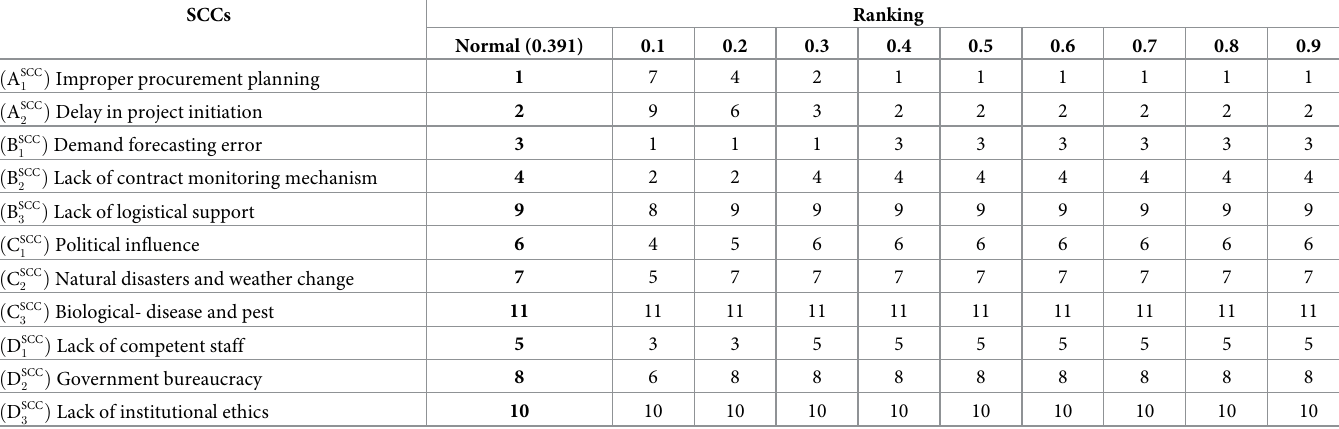
Table 4. Ranking of the challenges obtained from BWM, and sensitivity analysis.